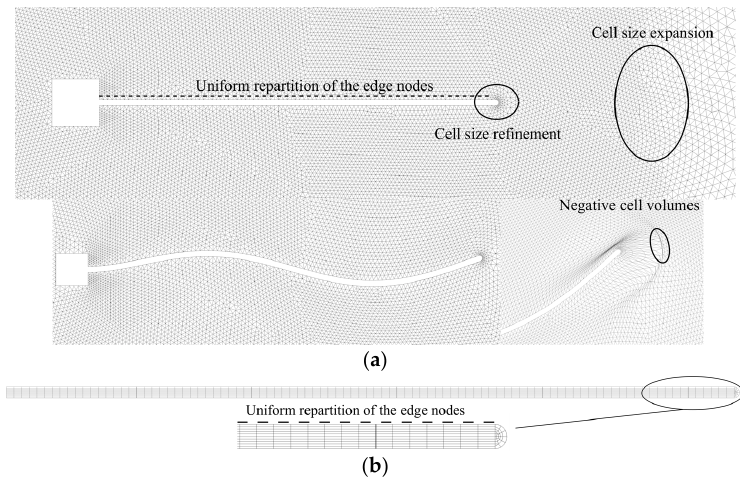
Figure 4. ( a ) Fluid mesh; ( b ) Solid mesh.